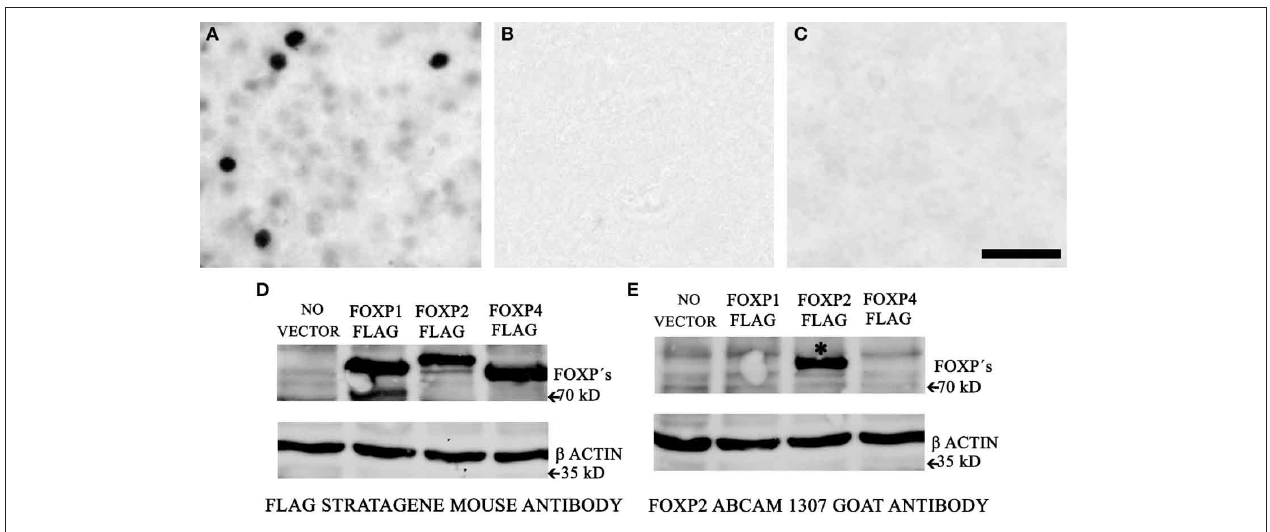
eliminates staining in Area X. Scale bar = 50 µ m. (D) Western blot of protein extracts from HeLa cells without vector or overexpressing FLAG-tagged FoxP1, or FLAG-tagged FoxP2, or FLAG-tagged FoxP4 probed with an anti-FLAG antibody detects the FLAG epitope of the tagged FoxP proteins. (E) Western blot of the same cell extracts as in (D) using the AbCam 1307 anti-FoxP2 antibody specifically detects FoxP2 (asterisk) but not FoxP1 or